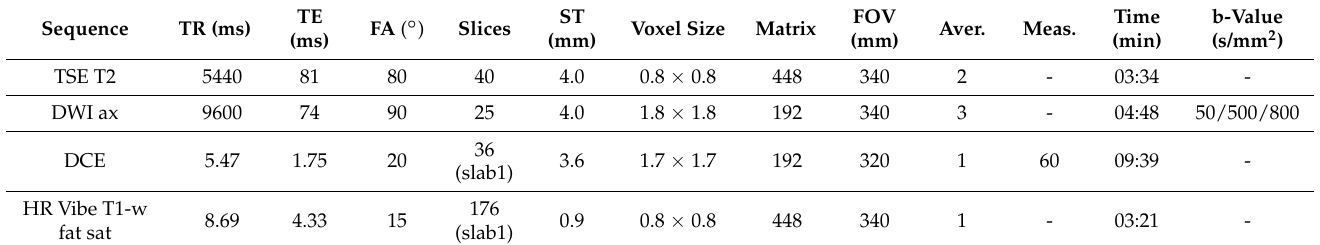
Table 1. Technical details of acquired MRI sequences. TR = Repetition Time; TE = Time to Echo; FA = Flip Angle; ST = Slice Thickness; FOV = Field Of View; Aver. = average; Meas. =